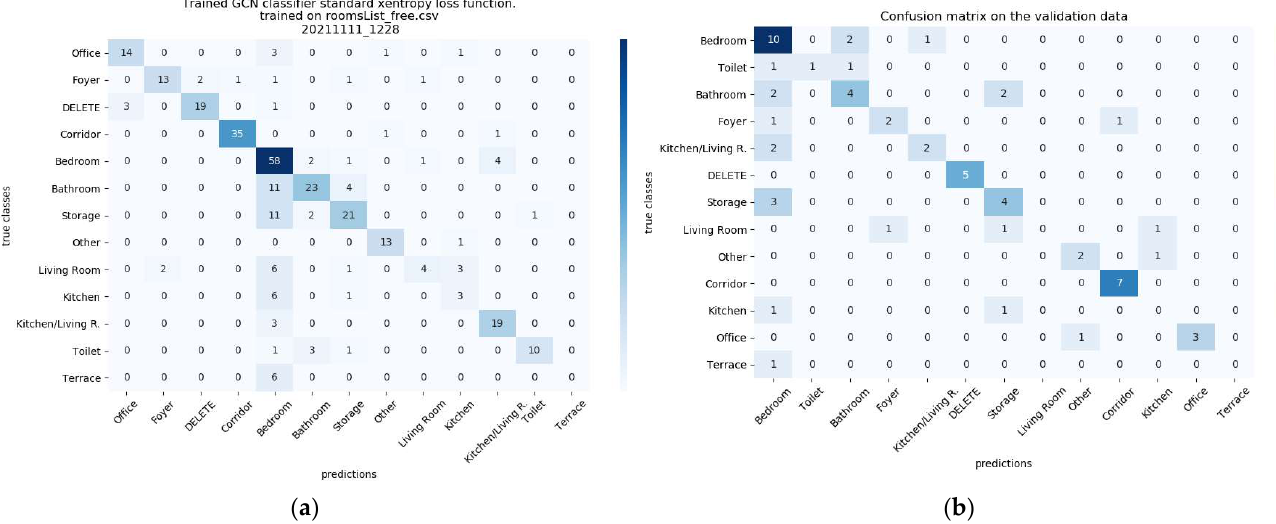
( b ) Figure 4. ( a ) An IFC model visualized with BIMVision software (https://bimvision.eu/, accessed on 15 January 2022). ( b ) The output of our WGCN space classifier for the spaces on the two floors of the building model. Figure 5 shows the confusion matrix for the inductive inference test. Some prediction errors are understandable; for example, the network often mistakes Corridors for Foyers (14 times). The IfcSanitaryTerminal elements (used to represent elements such as drains, water closets, or sinks) were not used as space features, as around half of the used models